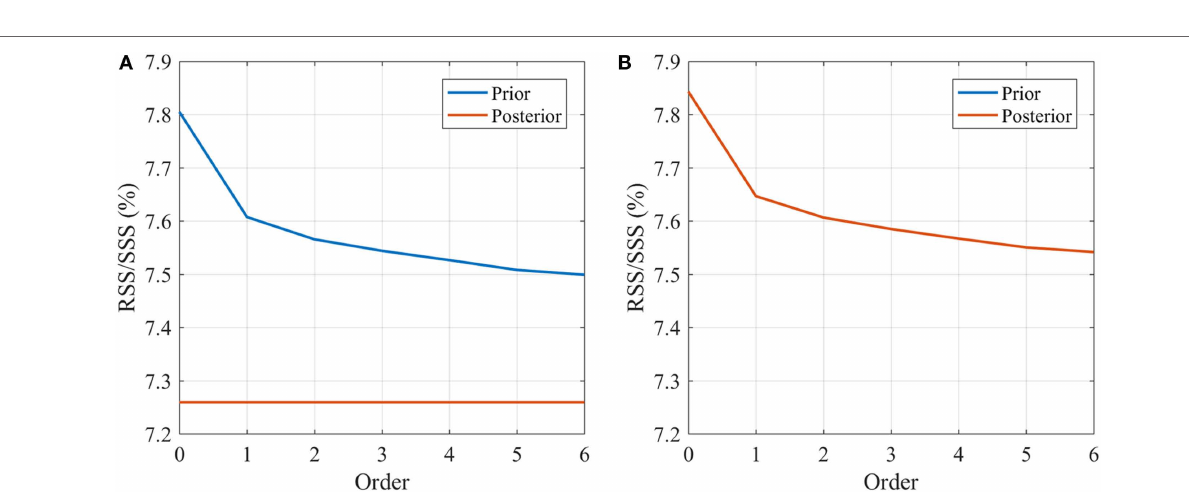
Frontiers in Built Environment |